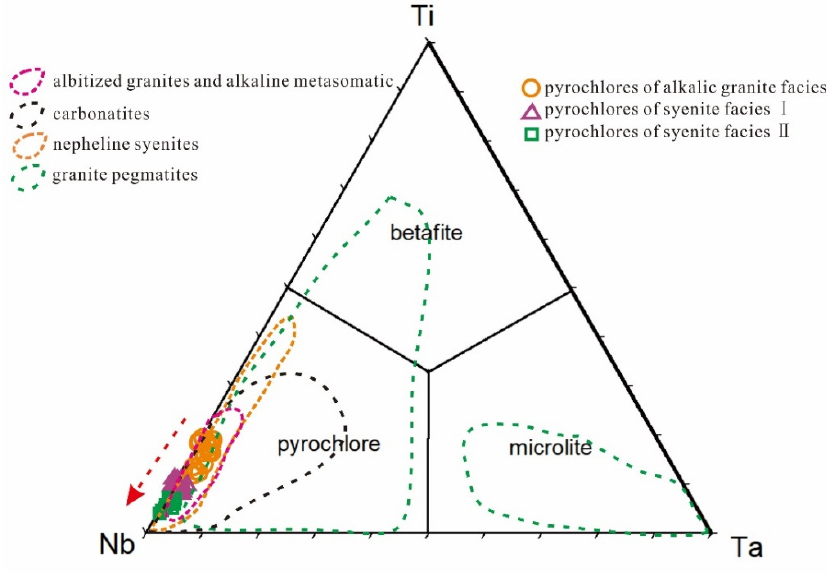
Figure 7. Triangular Nb–Ti–Ta pyrochlore classification scheme (modified by